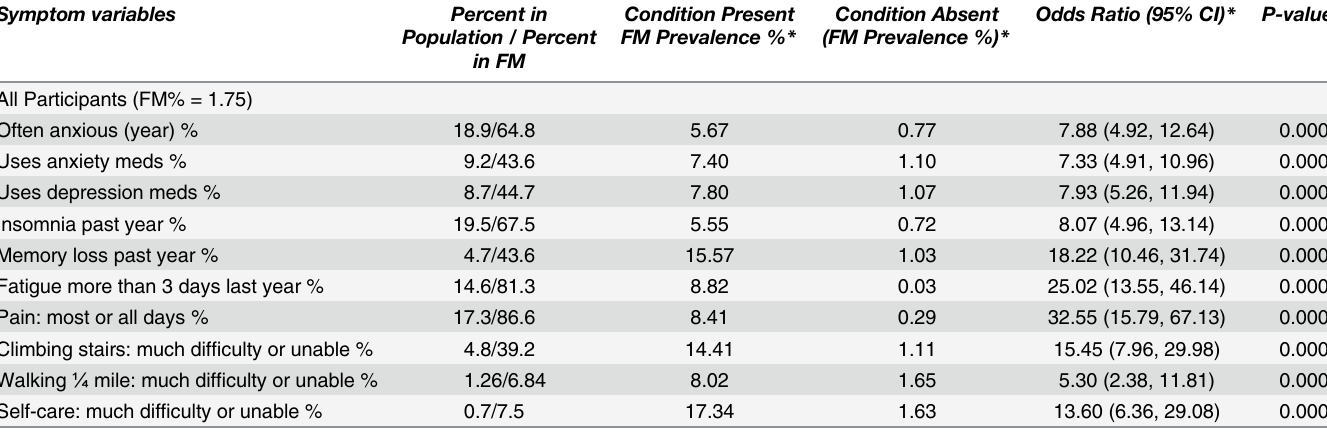
Table 5. Symptom and functional ability variable association with